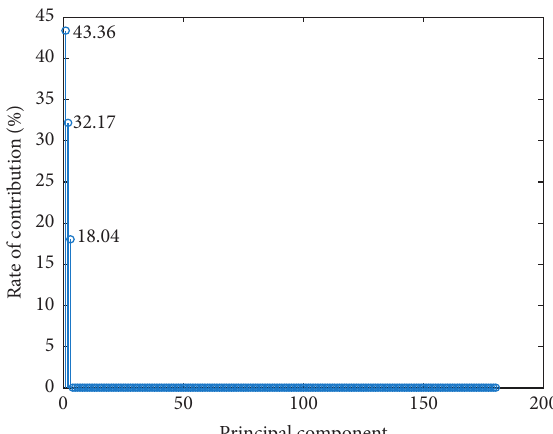
Figure 6: Contribution rate of principal components.